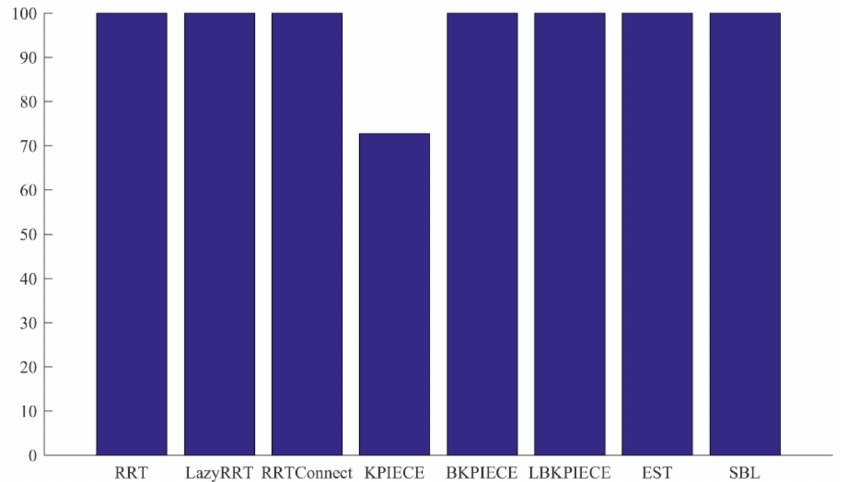
Figure 15. Success rate of Prubot manipulator in test 2 for each of the path planning